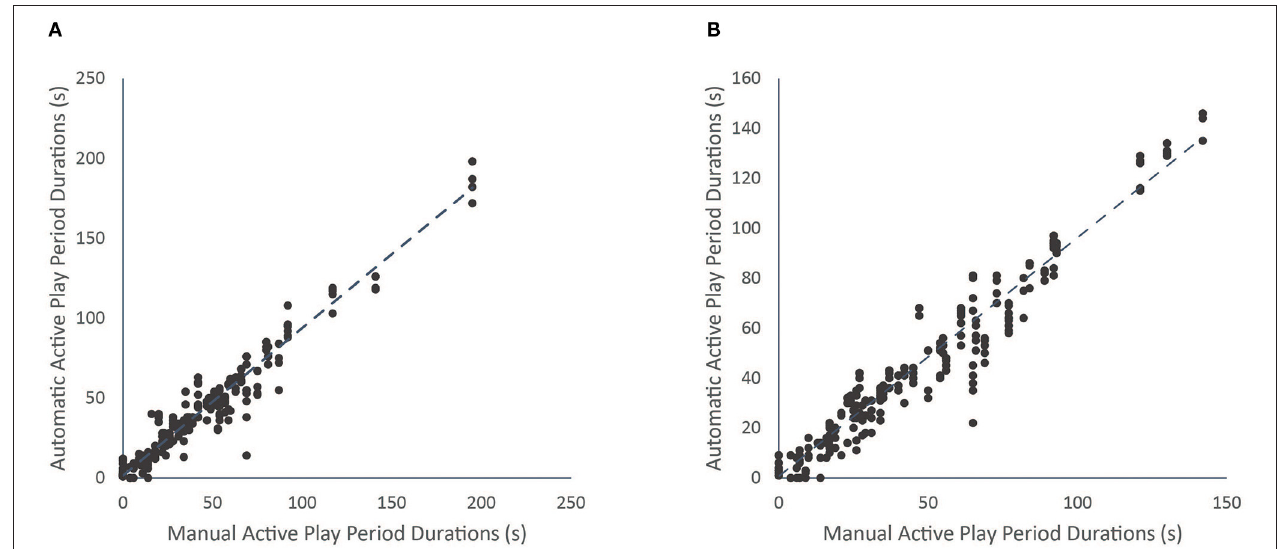
FIGURE 2 | Correlation between the manually and automatically determined live play period durations for the men’s match (A) and the women’s match (B) .